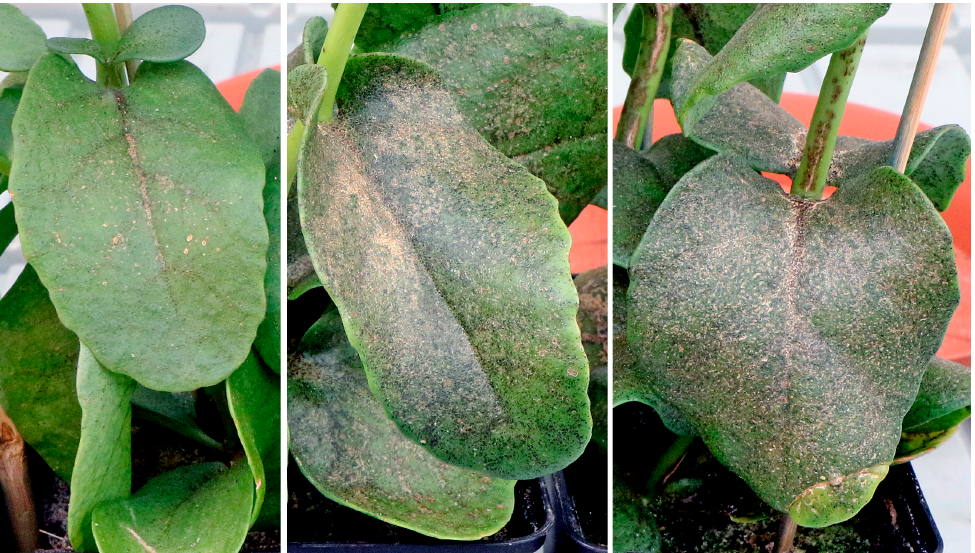
Figure 8. Typical visual toxicity symptoms on leaves of H. maximum plants treated with 0.5 ( left ), 1.0 ( middle ), and 2.0 ( right ) g L –1 Mn eight weeks after full treatment (Experiment 2).